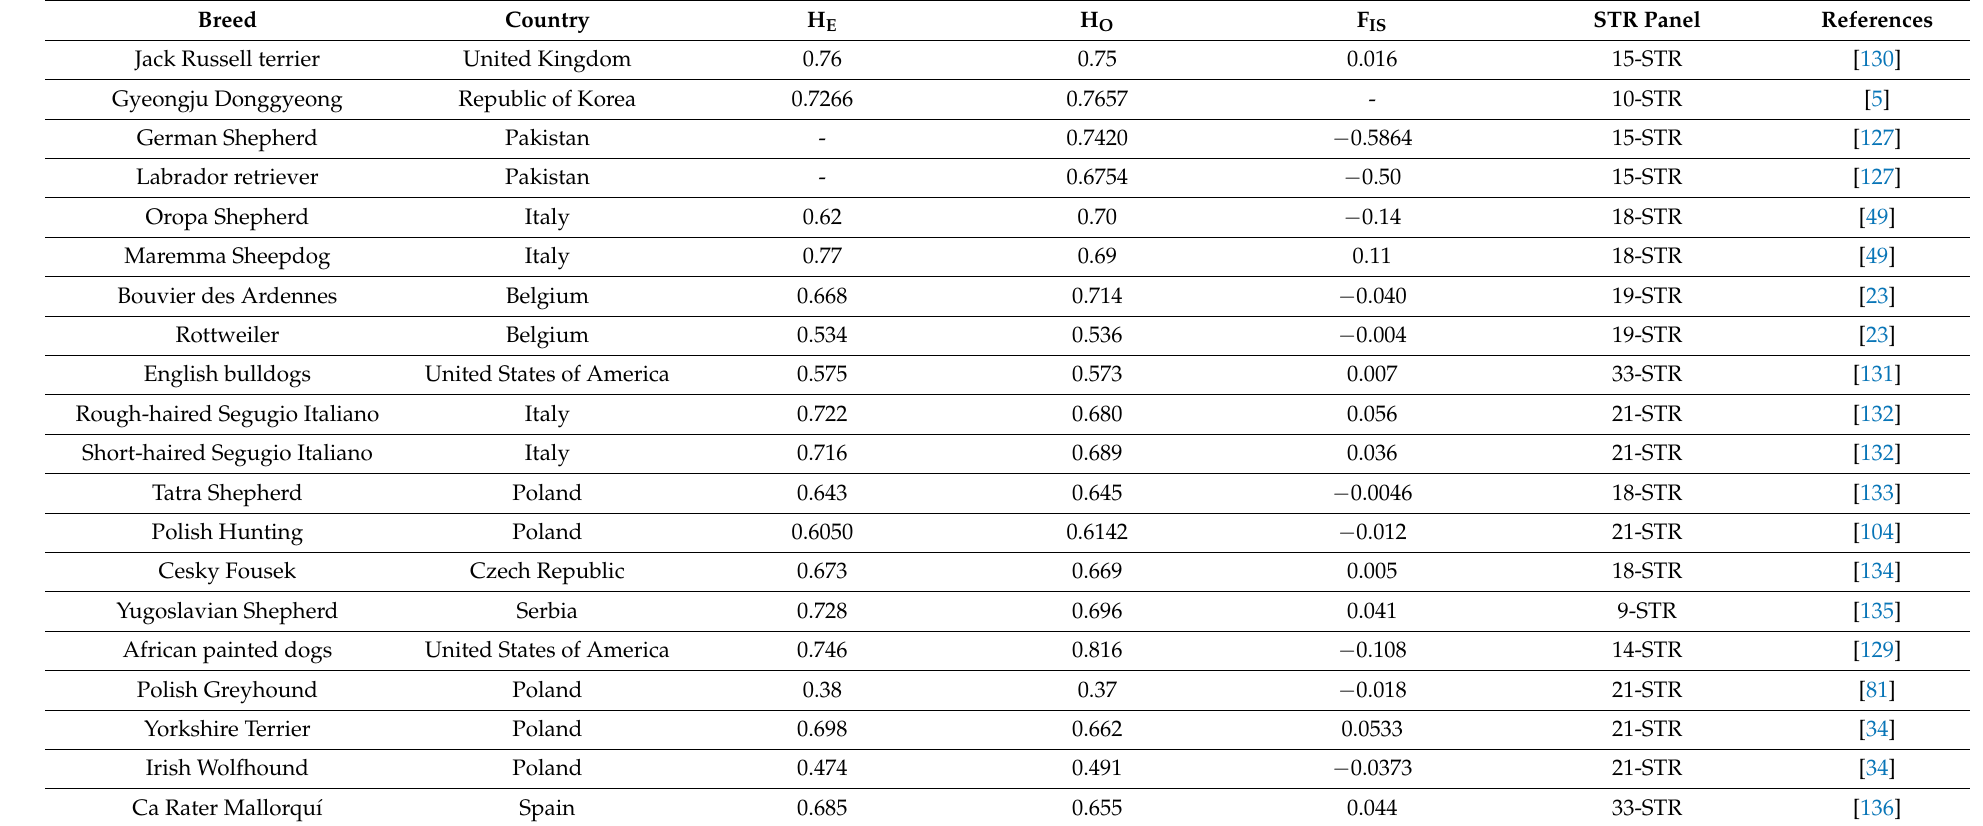
Table 3. Molecular genetic diversity on dog breeds using microsatellite